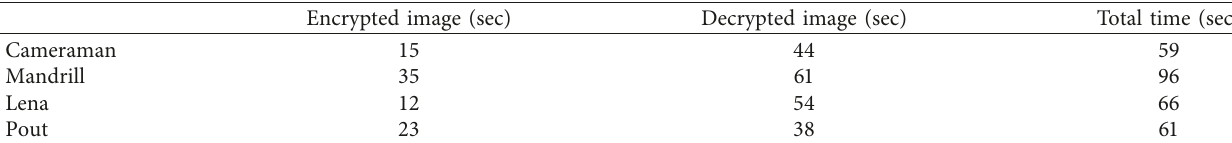
Table 5: Performance of computational time.